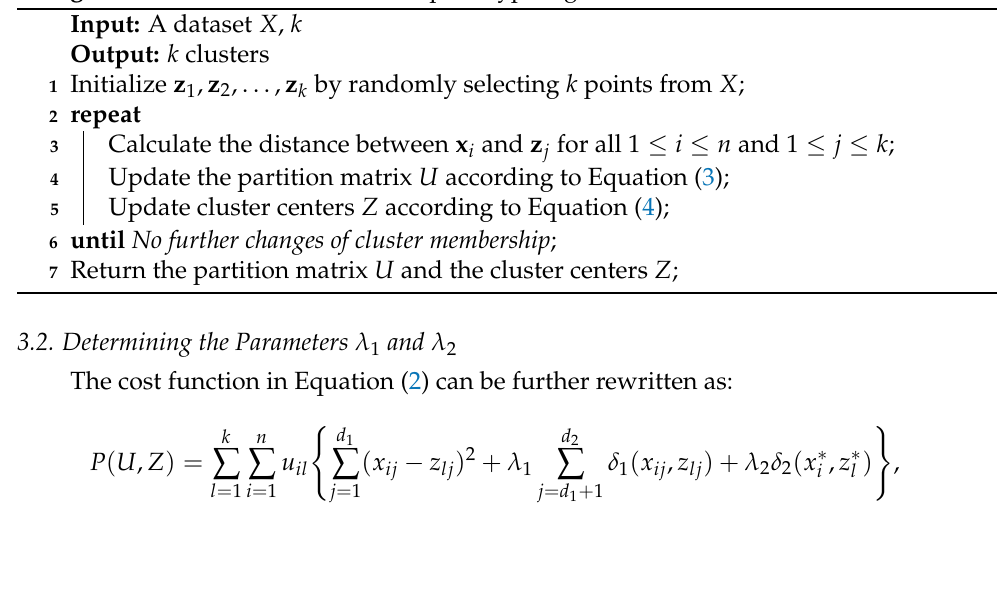
Algorithm 1: Pseudo-code of the k -prototype